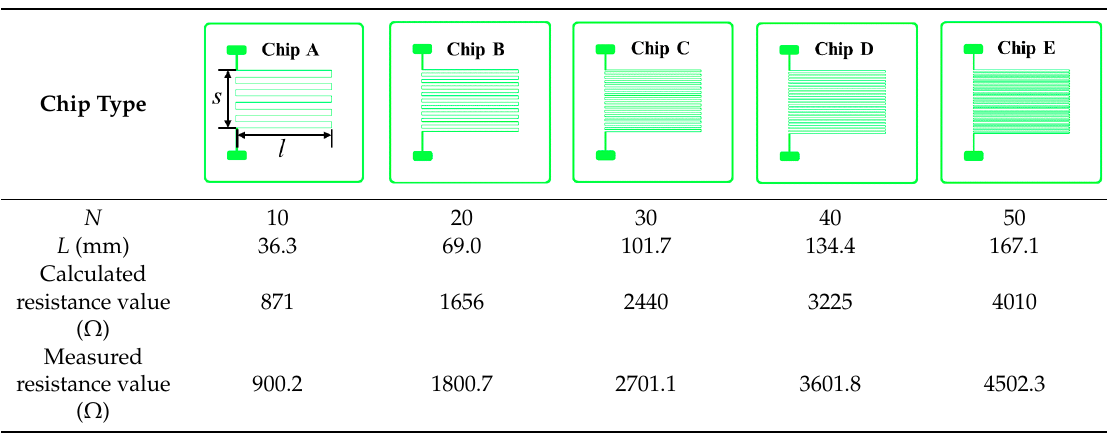
Table 1. Design parameters of gold-film temperature sensor.